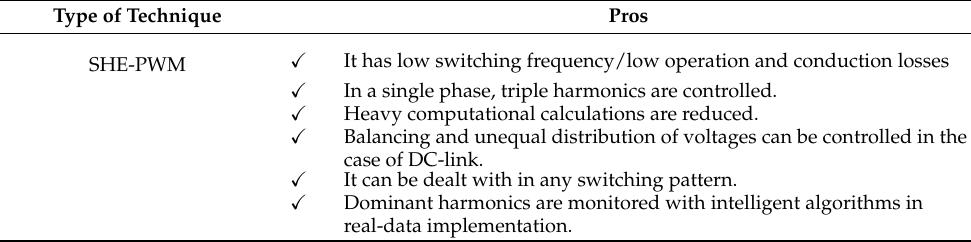
Table 3. SHE-PWM technique advantages.